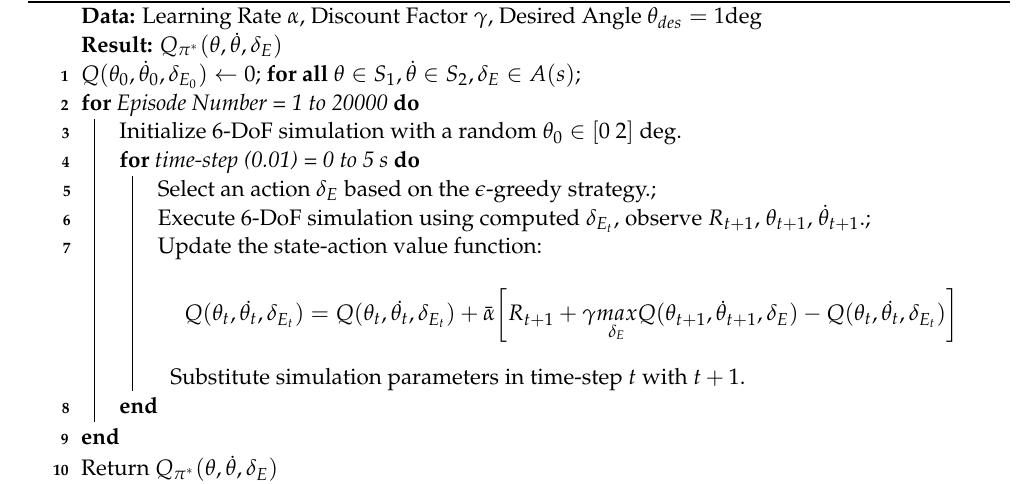
Algorithm 1: Q-learning Aircraft Attitude